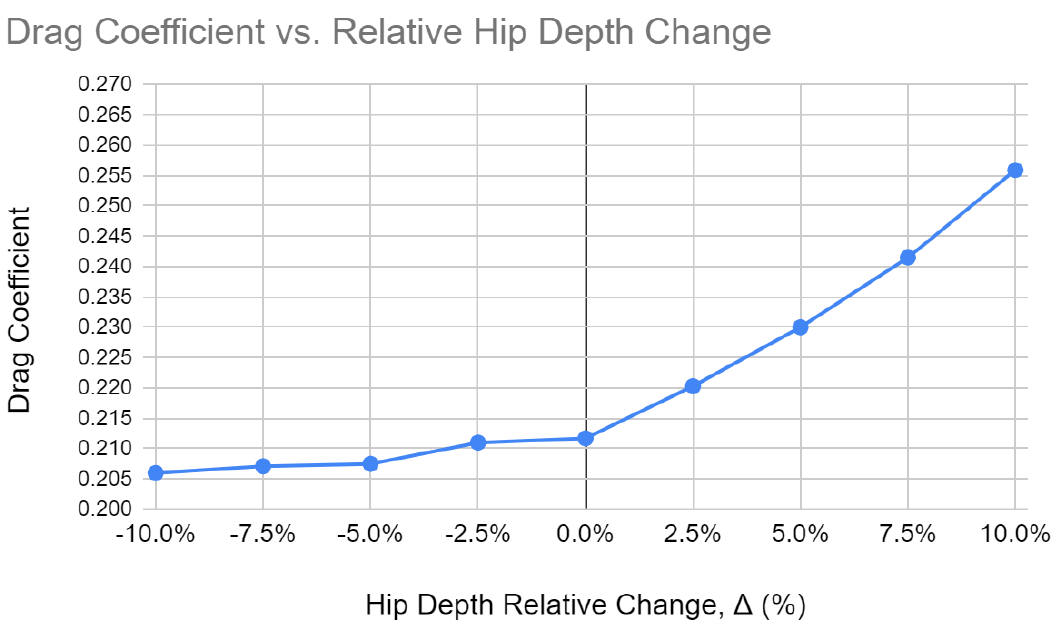
Figure 11. Graph of Relative Hip Depth Change (side view model) vs. Drag Coefficient.